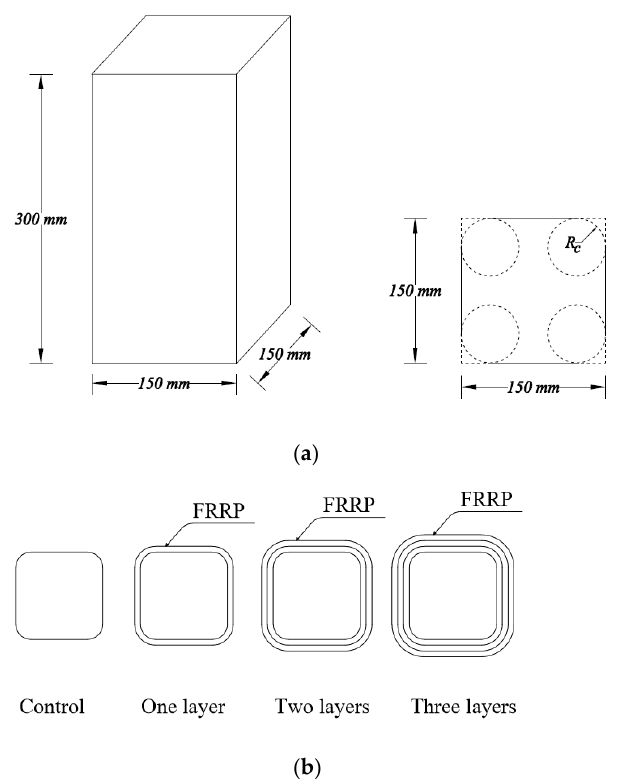
Figure 1. Details of specimens. ( a ) Unconfined specimen. ( b ) Details of FRRP confinement.